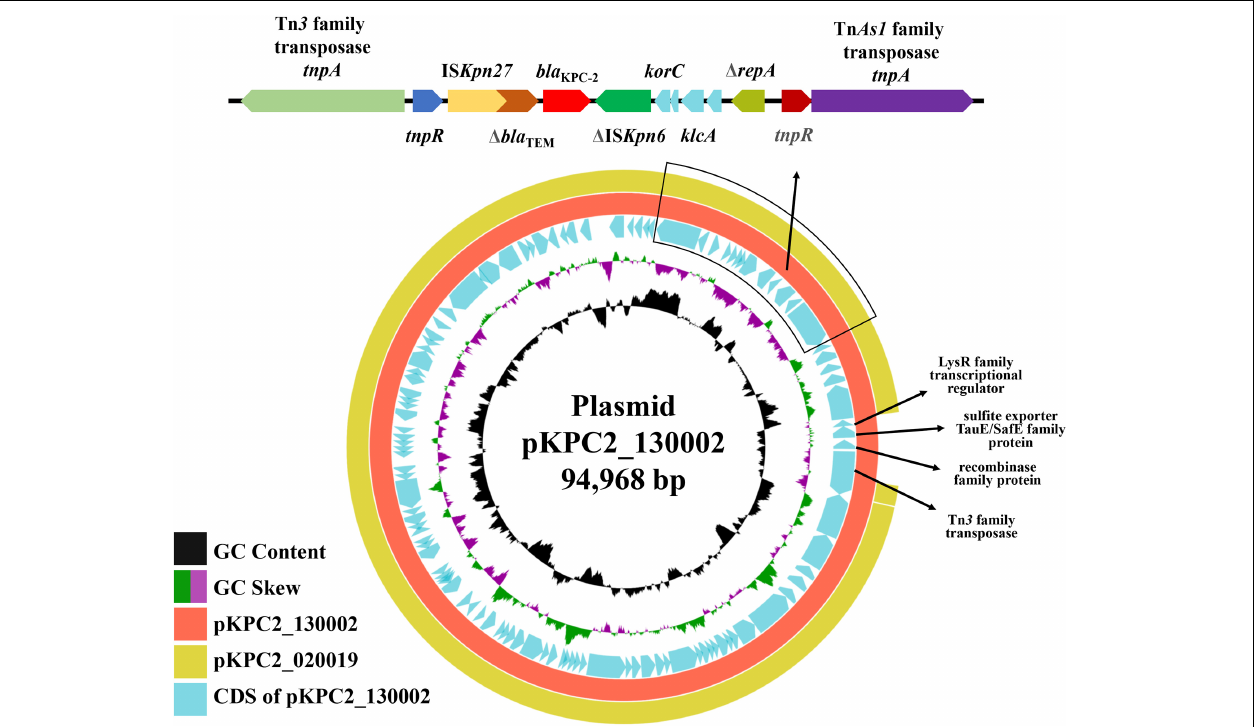
FIGURE 2 | Alignment of pKPC2_130002 with pKPC2_020019. pKPC2_130002 is a 94.9-kb IncFII plasmid of the Y6:A-:B- type and has bla KPC − 2 . pKPC2_130002 is the closest to pKPC2_020019 (accession no. CP028554), an 89.7-kb Y6:A-:B-type bla KPC − 2 -carrying plasmid from a K. variicola strain recovered in a hospital of a neighbor city (Meishan, 80 km away from Chengdu) in 2017, with a 94% coverage and 99.93% identity. Comparing with pKPC2_130002, pKPC2_020019 lacks several protein-encoding genes with the products being indicated. On pKPC2_130002 and pKPC2_020019, bla KPC − 2 is located in a non-Tn 4401 element containing a transposase-encoding tnpA gene of an unnamed transposon of the Tn 3 family at upstream and another tnpA of an unnamed transposon of the Tn As1 family at downstream. This comparison was performed using BRIG (Alikhan et al., 2011) in the default settings.